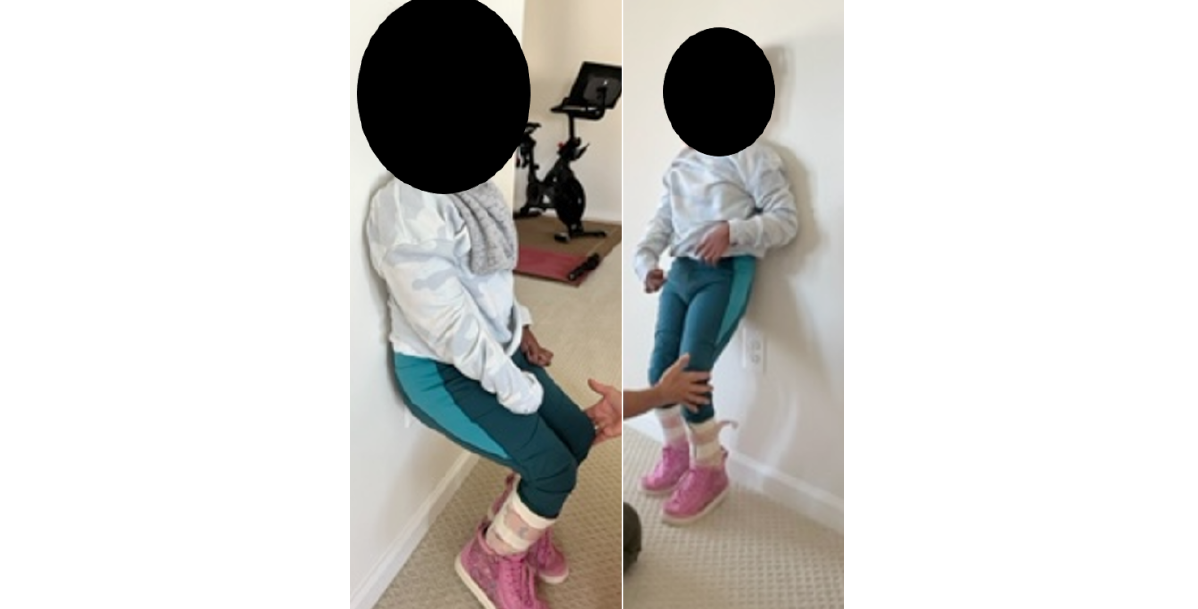
Figure 3. Left image was taken pre-IMES TX and the right image was taken post-IMES TX to the hamstring and gastrocnemius